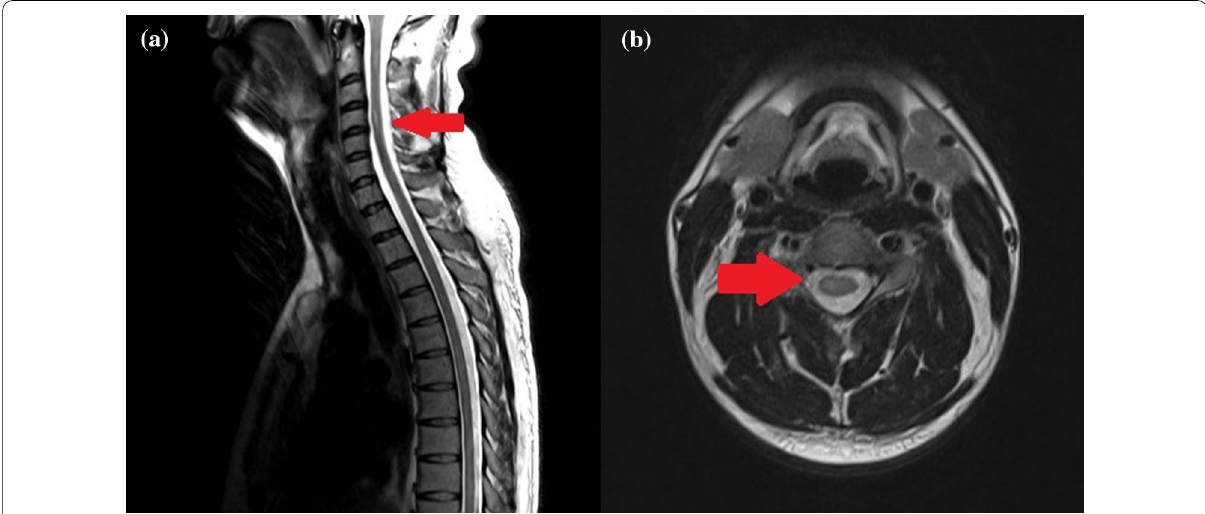
Fig. 1 a Multifocal T2 hyperintense signals involving the spinal cord. There are multiple skip segments without continuous involvement. The red arrows indicate T2 hyperintense signals in the spinal cord at C4 level in both sagittal ( a ) and axial planes (b )